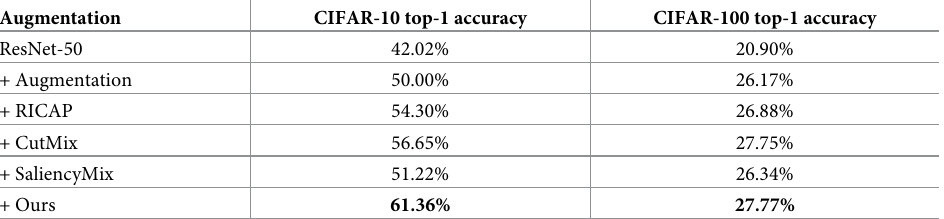
Table 8. Results of applying the ResNet-50 model trained on the CIFAR-10 and CIFAR-100 datasets using the FGSM